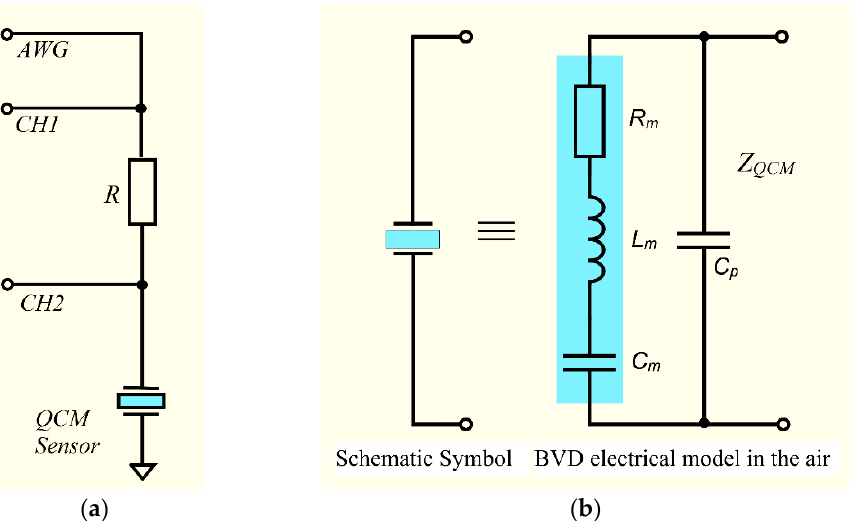
Figure 1. Virtual QCM: ( a ) Front-end circuit with QCM sensor connected to the ground, ( b ) Butter- worth van Dyke (BVD) model of the quartz crystal used as QCM sensor.